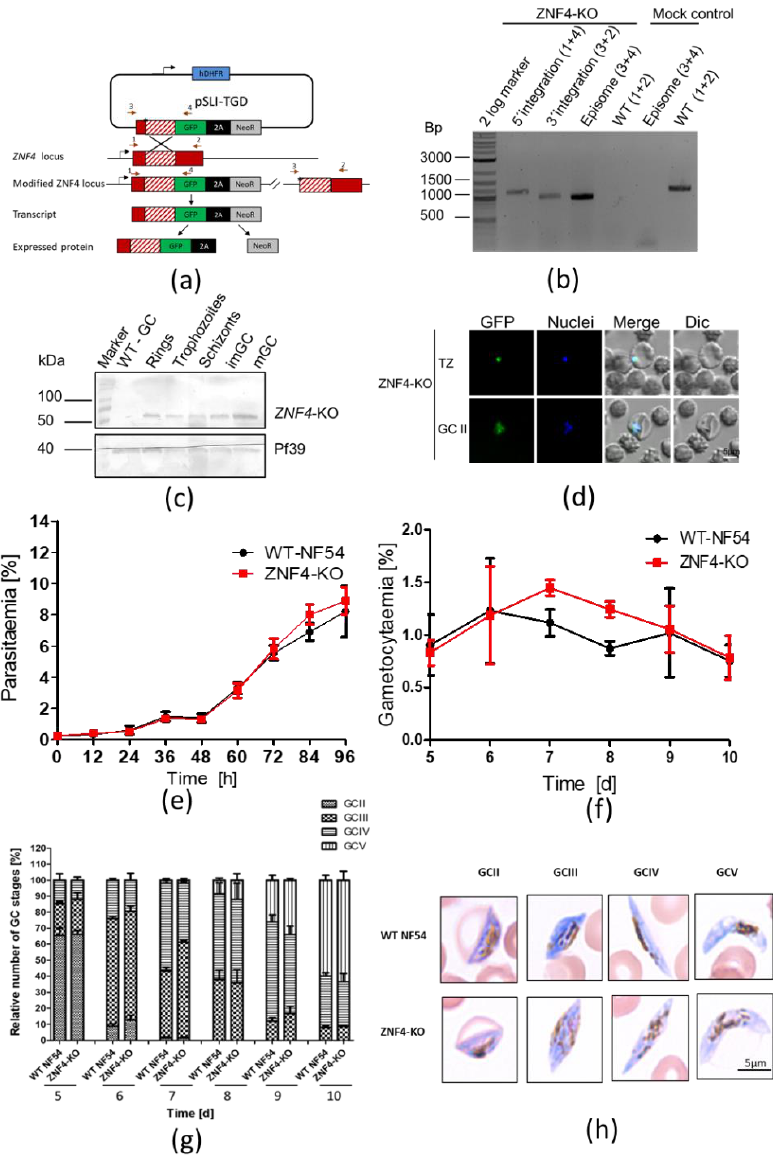
Figure 2. Targeted gene disruption of ZNF4 and its effect on asexual blood stage replication and gametocytogenesis: ( a ) Schematic depicting the generation of ZNF4-KO via single crossover recombination-based gene disruption using selective linked integration targeted gene disruption (SLI-TGD). The vector pSLI-TGD was modified to contain a 601 bp sequence block (white box with red stripes) from near the 5 ′ end of the ZNF4 coding region (red box). The coding region was maintained in frame with a GFP protein coding region (green box), a 2A “skip” peptide (black box), and the Neo-R gene (grey) that provides resistance to the antibiotic G418. Arrows indicate the position of primers 1–4, used to detect integration of the pSLI-TGD vector. Asterisks indicate a stop codon. GFP, green fluorescent protein; hDHFR; human dehydrofolate reductase for resistance to WR99210; NeoR, neomycin-resistance; 2A, skip peptide. ( b ) Confirmation of vector integration for the ZNF4-KO parasites by diagnostic PCR using gDNA obtained from ZNF4-KO and WT-NF54. 5 ′ -integration was detected using primers 1 and 4 (1164 bp) and 3 ′ -integration using primers 3 and 2 (955 bp). Primers 3 and 4 were used to detect the presence of episome (965 bp), and primers 1 and 2 were used for WT control (1194 bp). ( c ) Confirmation of truncated ZNF4 tagged with GFP. Parasite lysates obtained from different stages of the ZNF4-KO parasite line were subjected to Western blotting using polyclonal mouse anti-GFP (estimated size 53 kDa). Lysate from WT mature gametocyte was used as negative control. Immunoblotting with mouse anti-Pf39 antisera (39 kDa) served as a loading control. ( d ) Verification of GFP expression in the ZNF4-KO parasites by live imaging. Live images of trophozoites (TZ) and gametocyte stage II (GCII) of the ZNF4-KO line detected GFP (green)